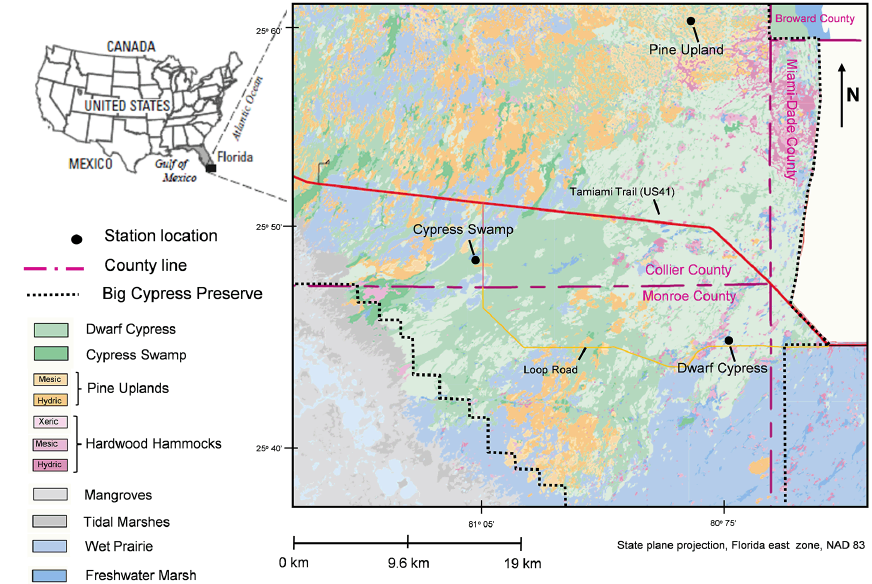
Figure 1. Location of the study area and vegetation communities, modified from Duever (2002).